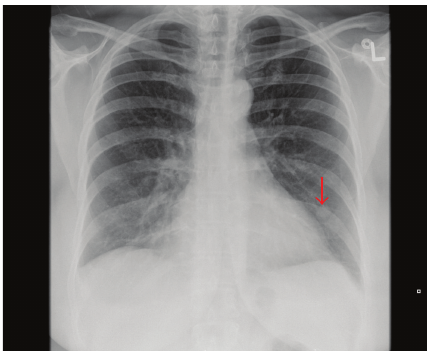
Figure 1: PA chest radiograph: there is a 1.3 cm nodule within the left lower lobe (arrow), projected lateral to the left cardiac